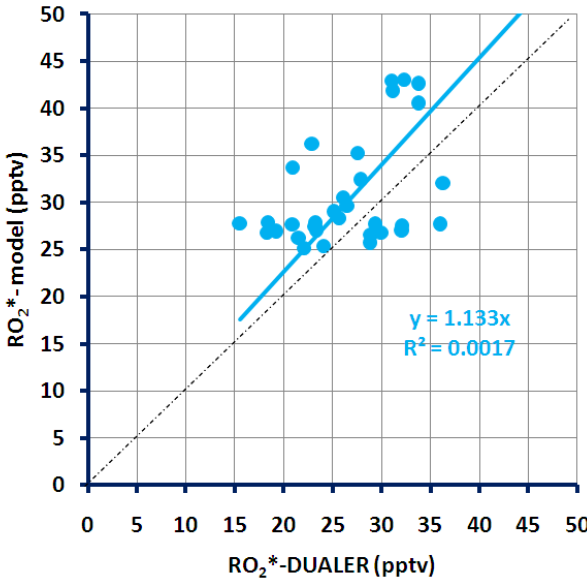
Fig. 12. [HO 2 +RO 2 ] model versus [RO ∗ 2 ] observations on board the D-Falcon for both altitudes during the AMMA intercomparison exercise. The model is constrained to j (NO 2 ) measured on board the D-Falcon scaled to the j (NO 2 )-BAe values measured at 697 hPa.